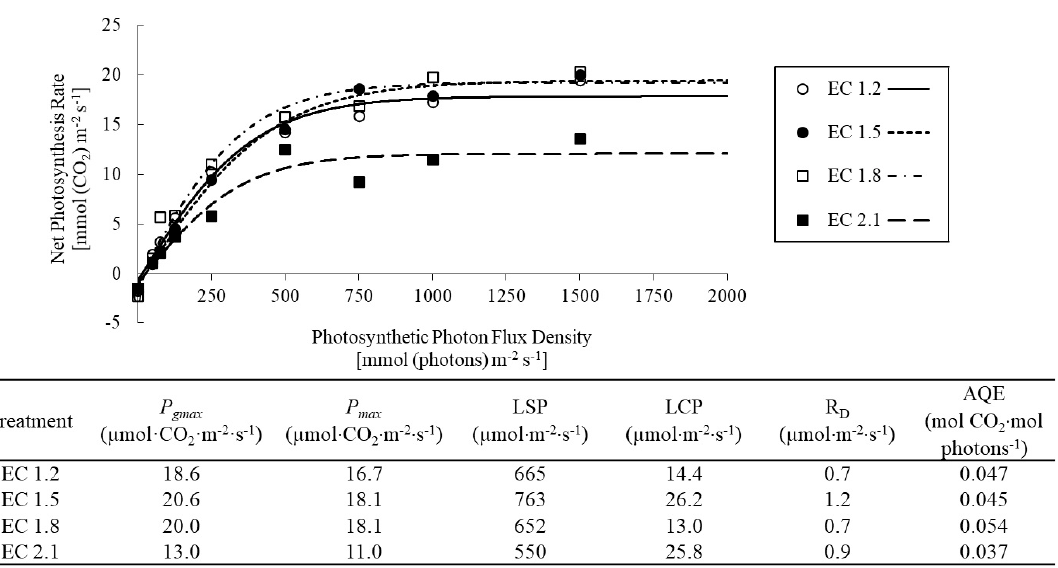
Figure 7. Effect of electrical conductivity (EC) of nutrient solution on the light response curve, maximum gross photo- synthetic rate ( P gmax ), maximum net photosynthetic rate ( P max ), light saturation point (LSP), light compensation point (LCP), respiratory rate (R D ), and apparent quantum yield (AQE) of arugula 4 weeks after transplanting into a nutrient-film technique hydroponic system containing nutrient solutions with EC of 1.2, 1.5, 1.8, or 2.1 dS · m − 1